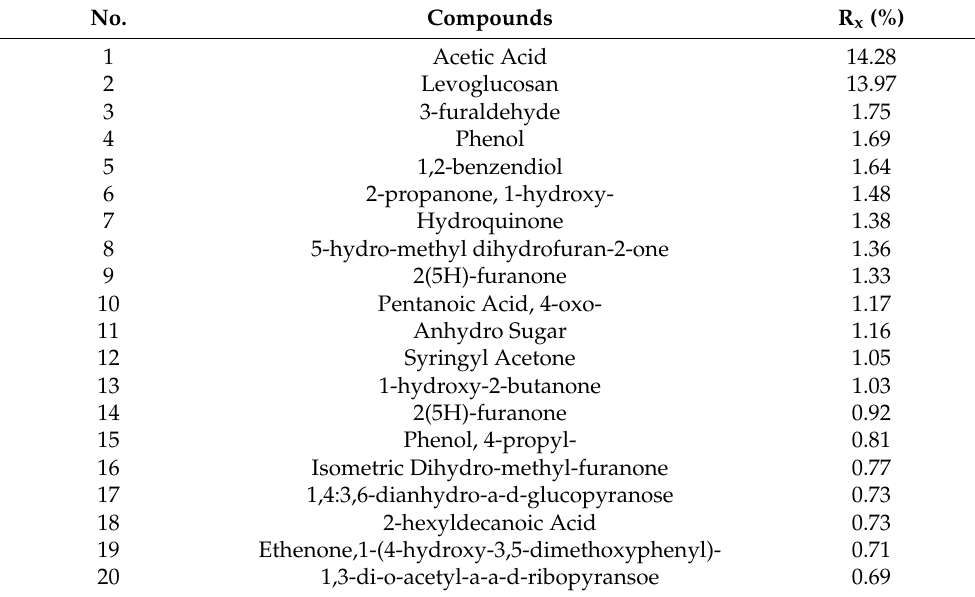
Table 3. Main chemical compounds in